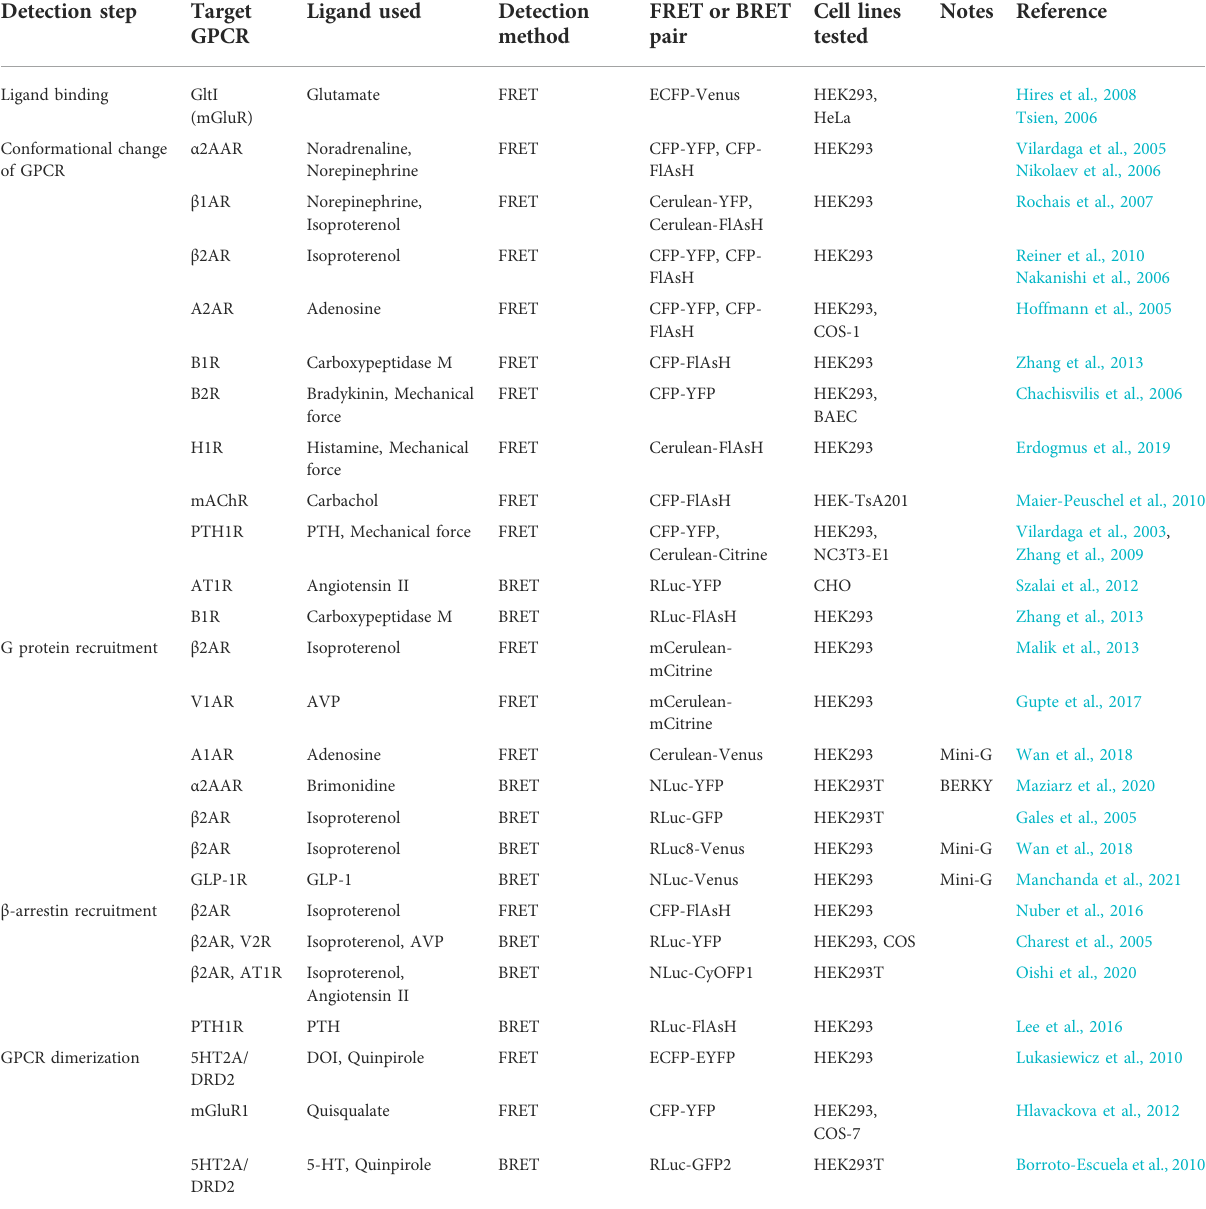
TABLE 1 Examples of currently available FRET and BRET biosensors for GPCR